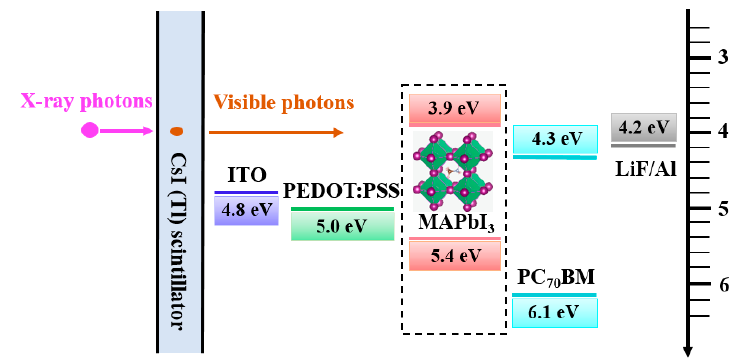
Figure 1. Energy-band diagram of the proposed detector with perovskite active layer.